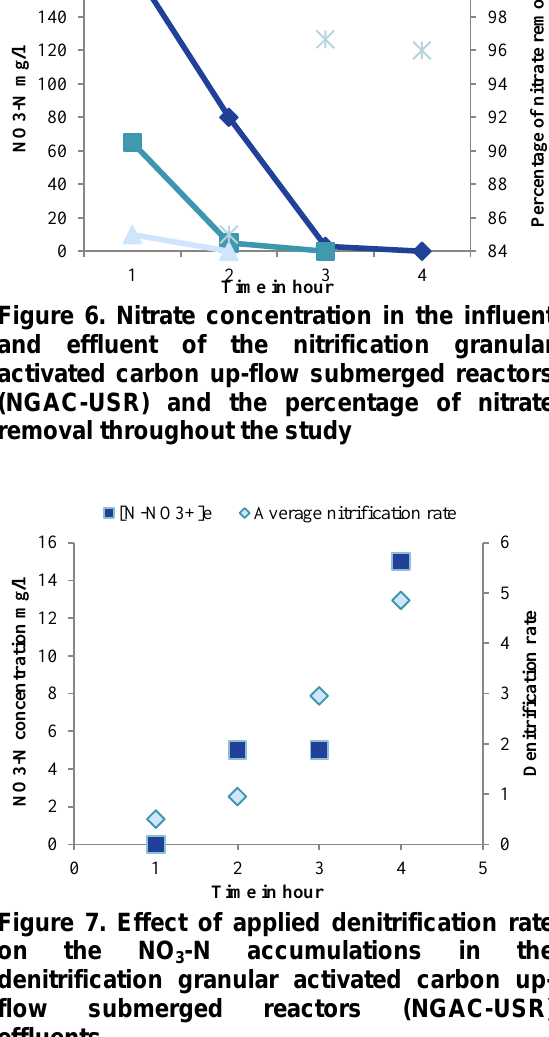
Figure 7. Effect of applied denitrification rate on the NO -N accumulations in the 3 denitrification granular activated carbon up- flow submerged reactors (NGAC-USR) effluents Saliling et al. reported a denitrification rate of 1.36 kg NO 3 -N/m 3 /day using a wood chips/wheat straw anoxic biofilter. 32 They evaluated wood chips and wheat straw